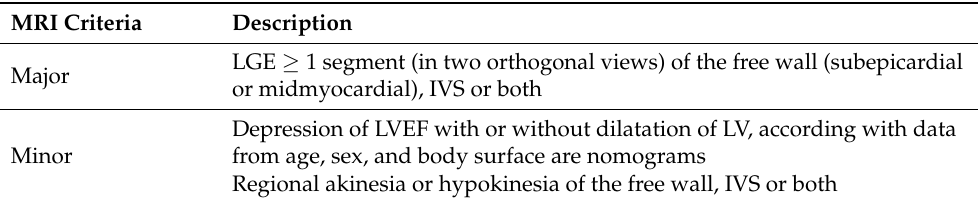
Table 3. Padua 2020 criteria for LV